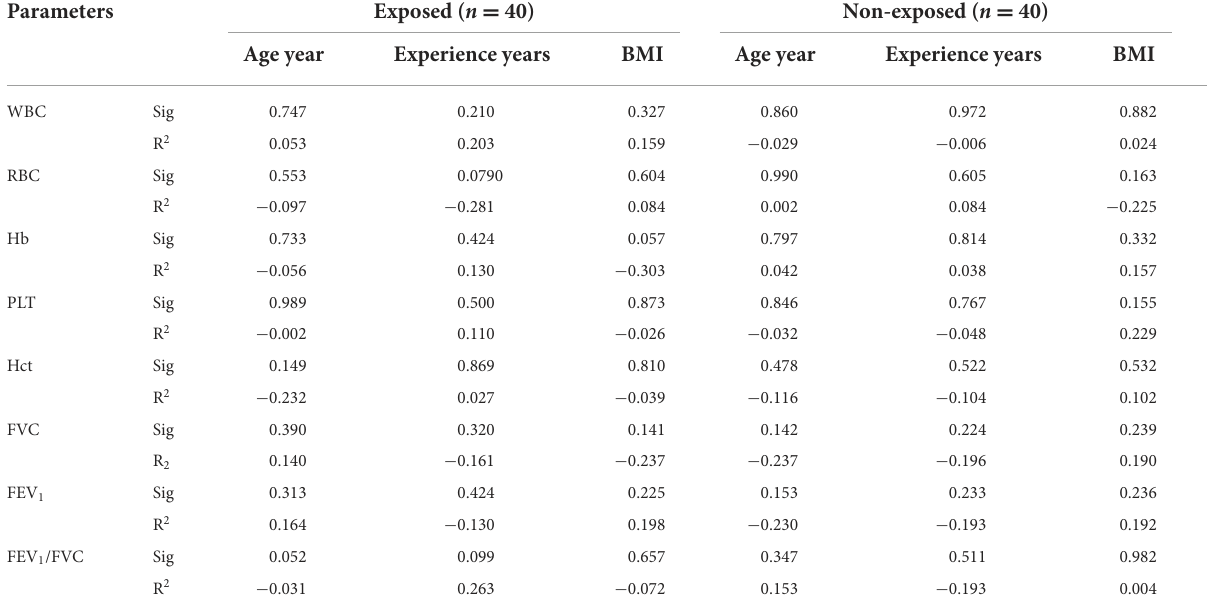
TABLE 4 Relationship between physiological parameters and demographic characteristics.